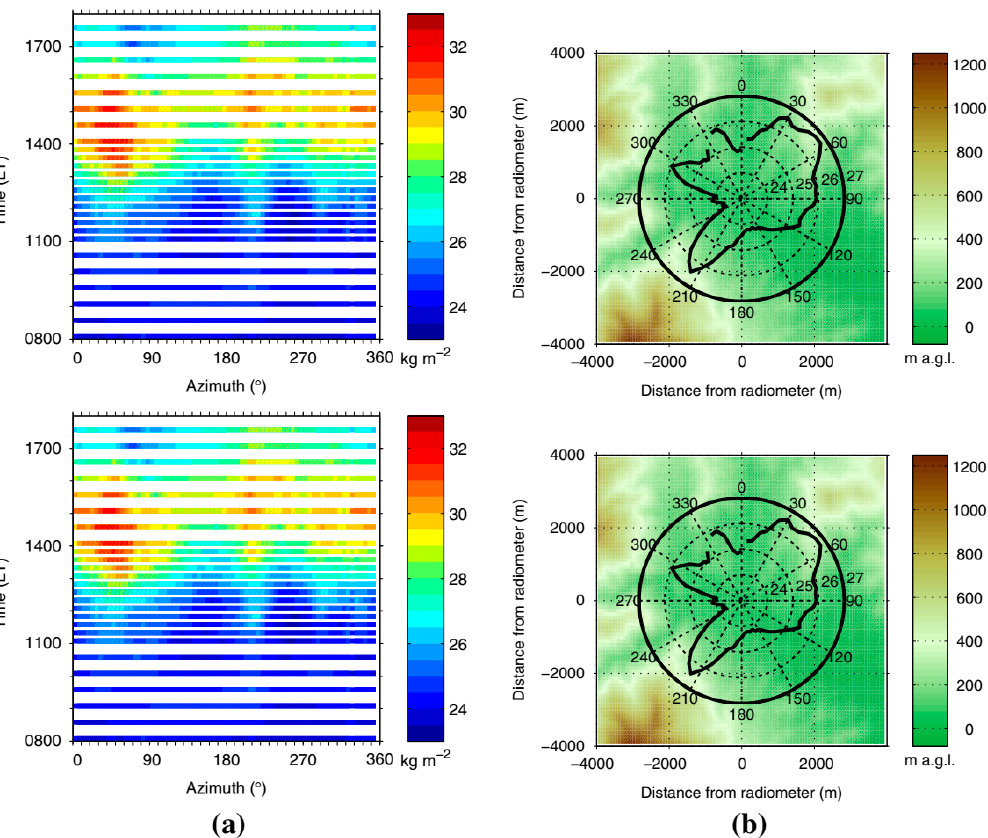
Figure 6. Azimuthal time plot of IWV (integrated water vapor) ( a ) and polar plot of IWV with underlying orography at 1200 Local Time (LT) ( b ) at Corte in Corsica on 19 August 2012 for an elevation angle of 19.8°. IWV was measured by a microwave radiometer. In ( b ), the orography is displayed in meters above ground relative to Corte (from [44], Reprinted by permission from Springer).